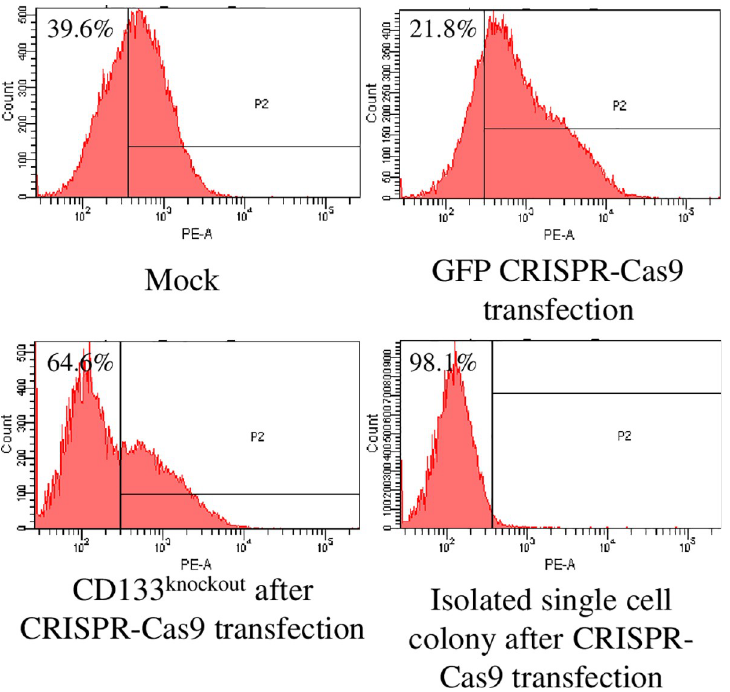
Fig 1. Validation of CD133 knockout by flow cytometry analysis. CRISPR-Cas9 mediated CD133 knockout group was composed of 64.6% CD133 - cells, in contrast to 39.6% and 21.8% in the mock and GFP group, respectively. After culturing isolated single cell colony from the CD133 CRISPR-Cas9 transfected cells, the proportion of purified CD133 knockout cells was 98.1%.